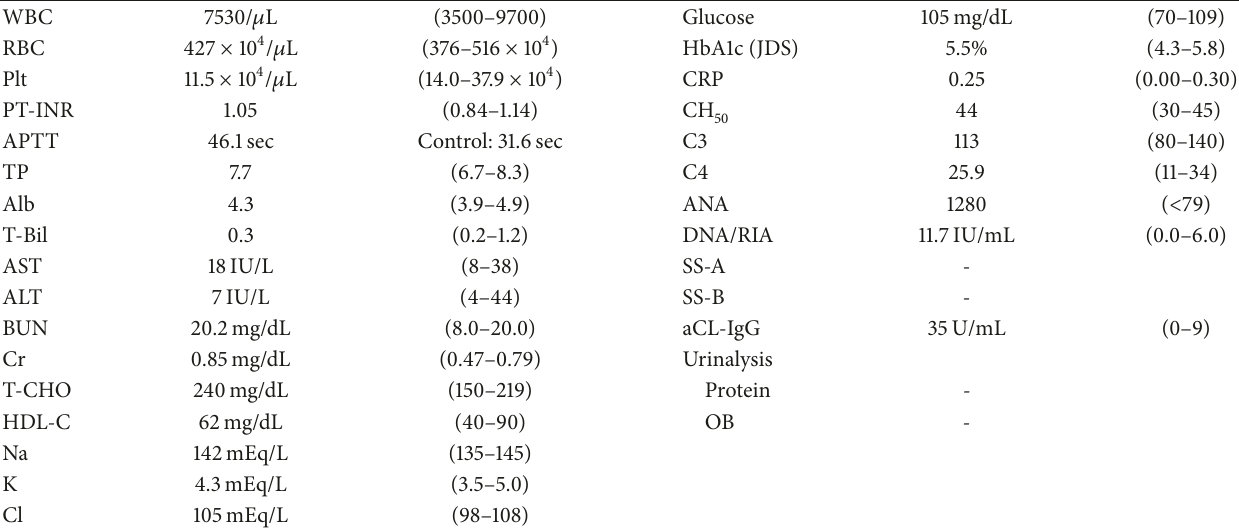
Table 1: Laboratory data of the patient.